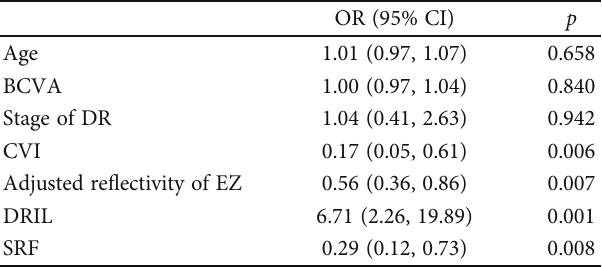
Table 3: Multifactor regression analysis for detecting the prognostic factors of the response to the antivascular endothelial growth factor (VEGF) treatment by a generalized estimating equation model with adjusting for correlation between two eyes within the same patient ( N = 92